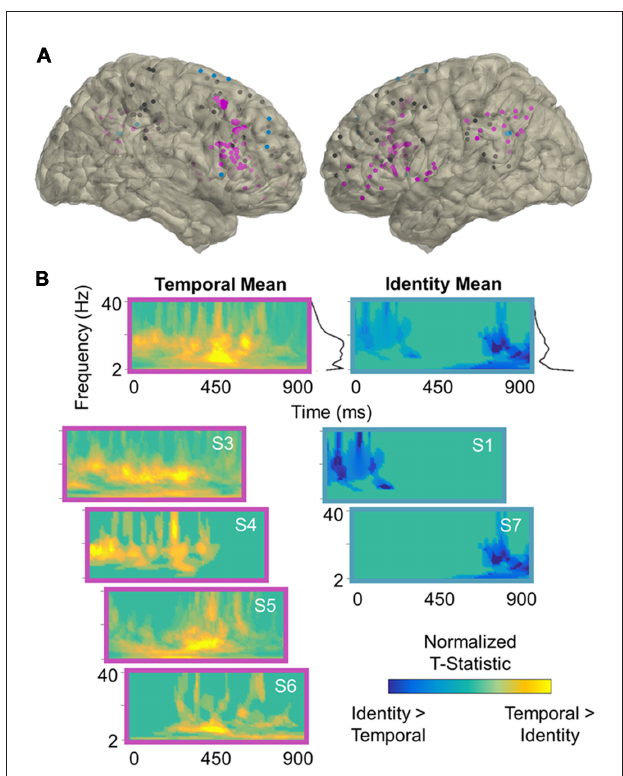
FIGURE 3 | Temporal processing power effects. (A) Reconstruction of frontoparietal electrode coverage for all subjects. Electrodes are color-coded according to the results of the per-subject contrast between identity and temporal trials: pink, temporal > identity; blue, identity > temporal; black, no effect. All effects are significant at the cluster-corrected threshold of 0.05. (B) Mean and per-subject time-frequency representations of significant t -statistics (cluster-corrected mask applied) for the electrodes indicated in (A) . The black lines to the right of the means indicate the spectral density of the corresponding time-frequency representations (i.e., mean significant t -values per frequency). Frequencies range from 2 Hz to 40 Hz in linearly-spaced steps of 1 Hz. T -statistics are normalized according to the maximum value of each plot (scale: − 1 to +1) and color-coded by the direction of effects: cooler, identity > temporal; warmer, temporal > identity. S,